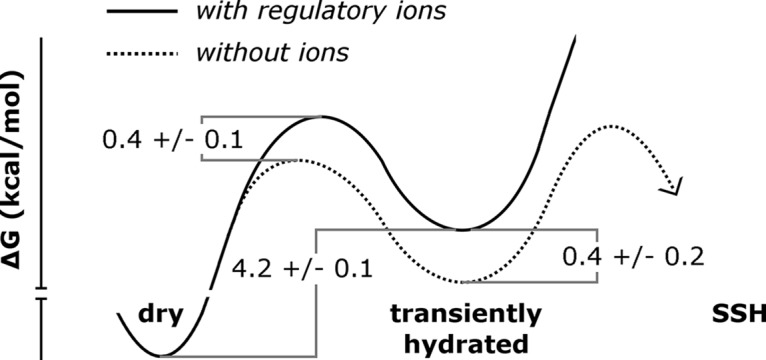
A model of hydrophobic gating in TmCorA.